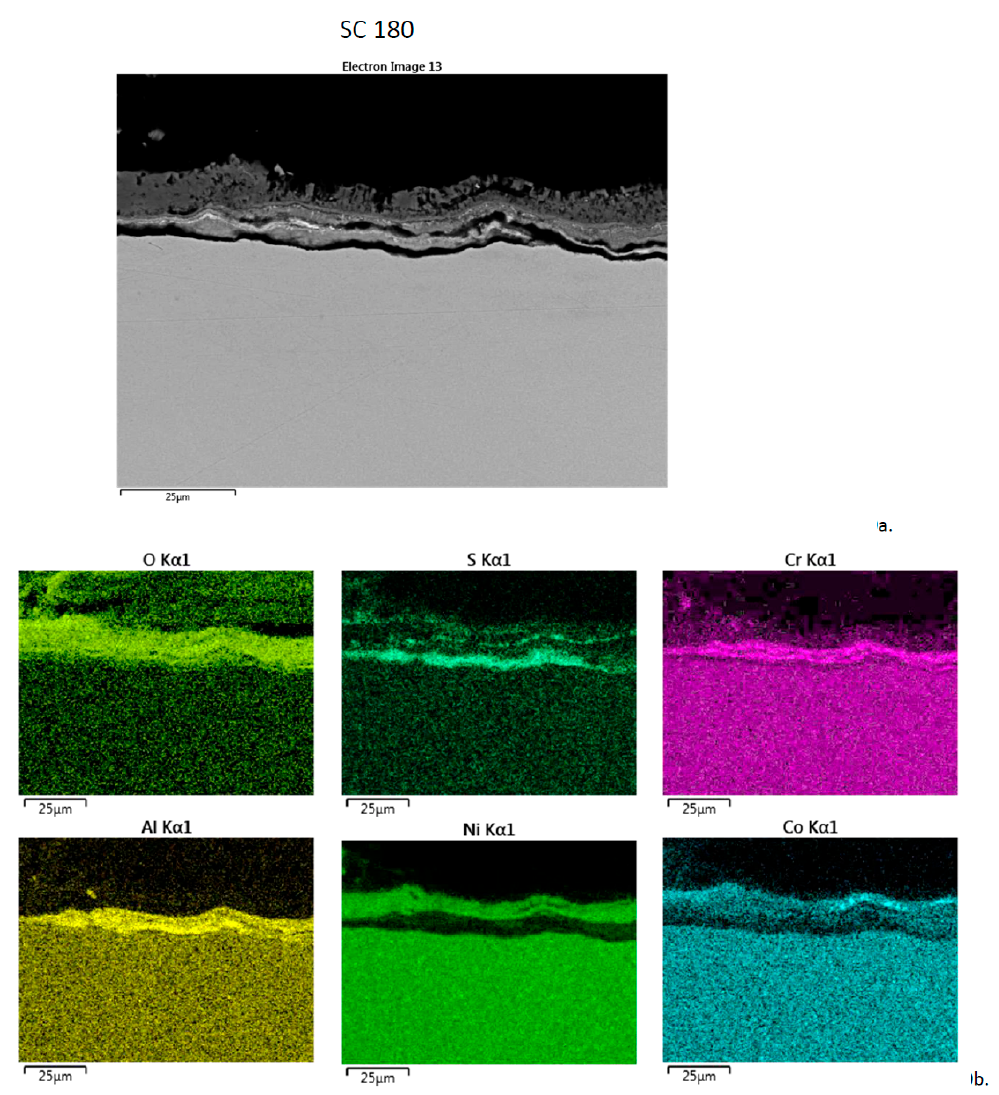
Figure 10. Cross-section of SC 180 sample after 300 h LTHC at 700 °C. ( a ) SE image showing two primary layers. ( b ) Elemental rasters for O, S, Cr, Al, Ni, Co showing inner Cr, Al, S bands and outer Ni, Co bands.